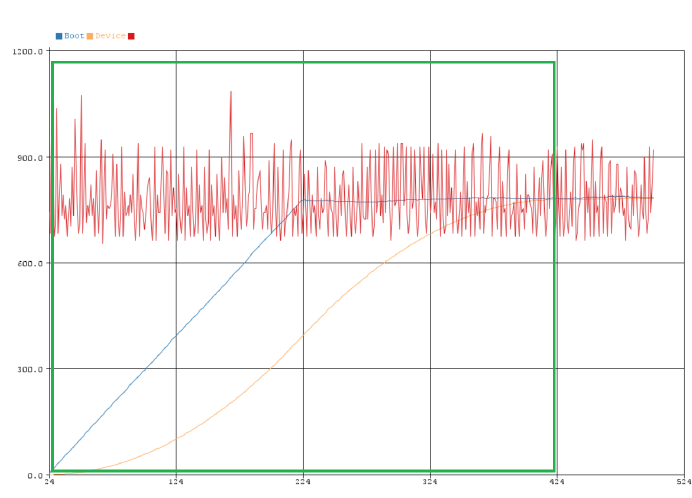
Figure 8. Boot Device Mode 1.